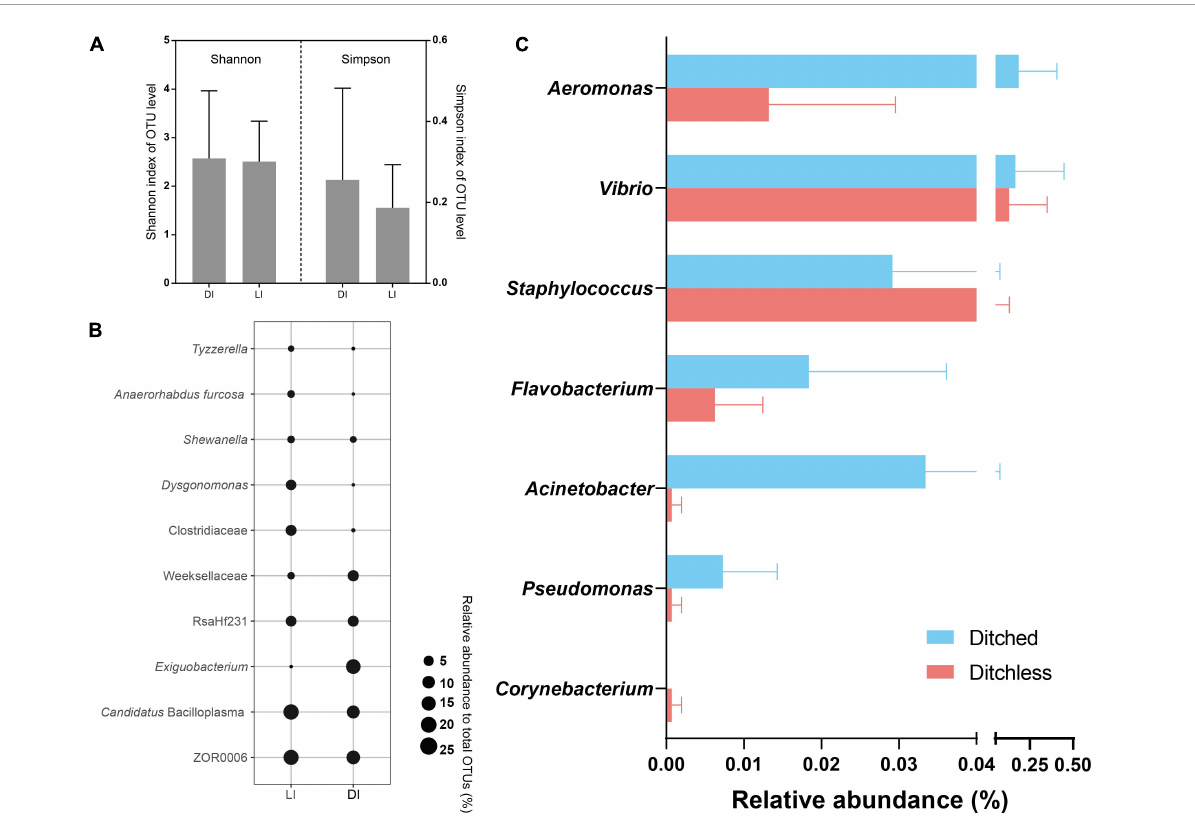
FIGURE4 Bacterial community structures of crayfish intestine in the ditched and the ditchless systems. (A) Alpha diversity index (Shannon and Simpson) of OTUs. (B) Bubble plots of the 10 most abundant OTUs. (C) The relative abundance of common harmful bacteria. All data are expressed as the mean ± s.d.